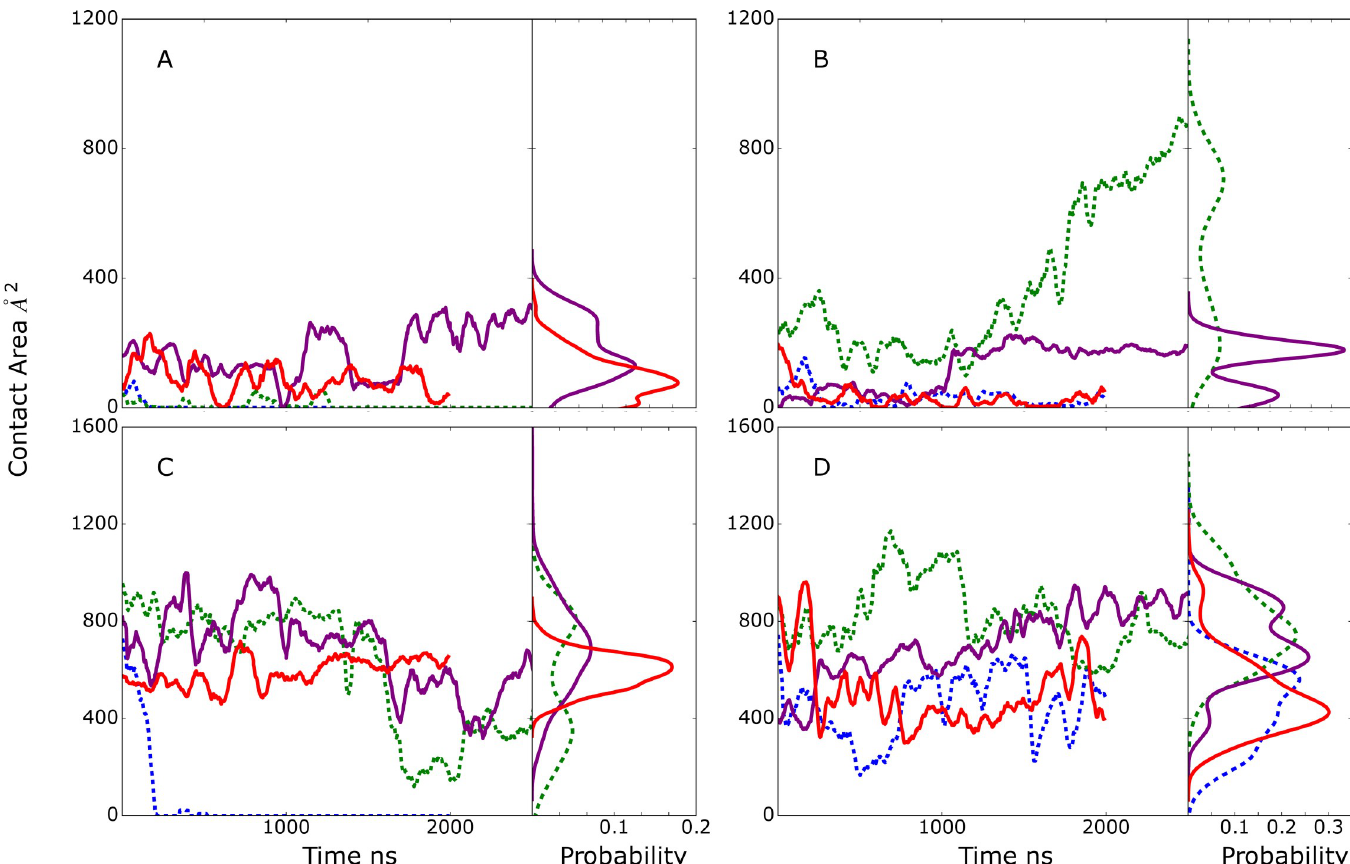
Fig 5. Model C time course and probability distributions of the contact area, Å 2 , between A) the selected glycan of the Fc and the CBM, B) the selected glycan of the Fc and the GH, C) the Fc protein CH2/CH3 domains hosting the selected glycan and the CBM, and D) the Fc protein CH2/CH3 domains hosting the selected glycan and the GH during the MD simulations. Results shown for individual MD simulations 1) blue, 2) green, 3) purple and 4) red. Data is presented as a 50 ns moving average. Dashed lines indicate in simulations 1 and 2 the Fc is monoglycosylated such that the CBM (panel A) and GH (panel B) are interacting with the same glycan.